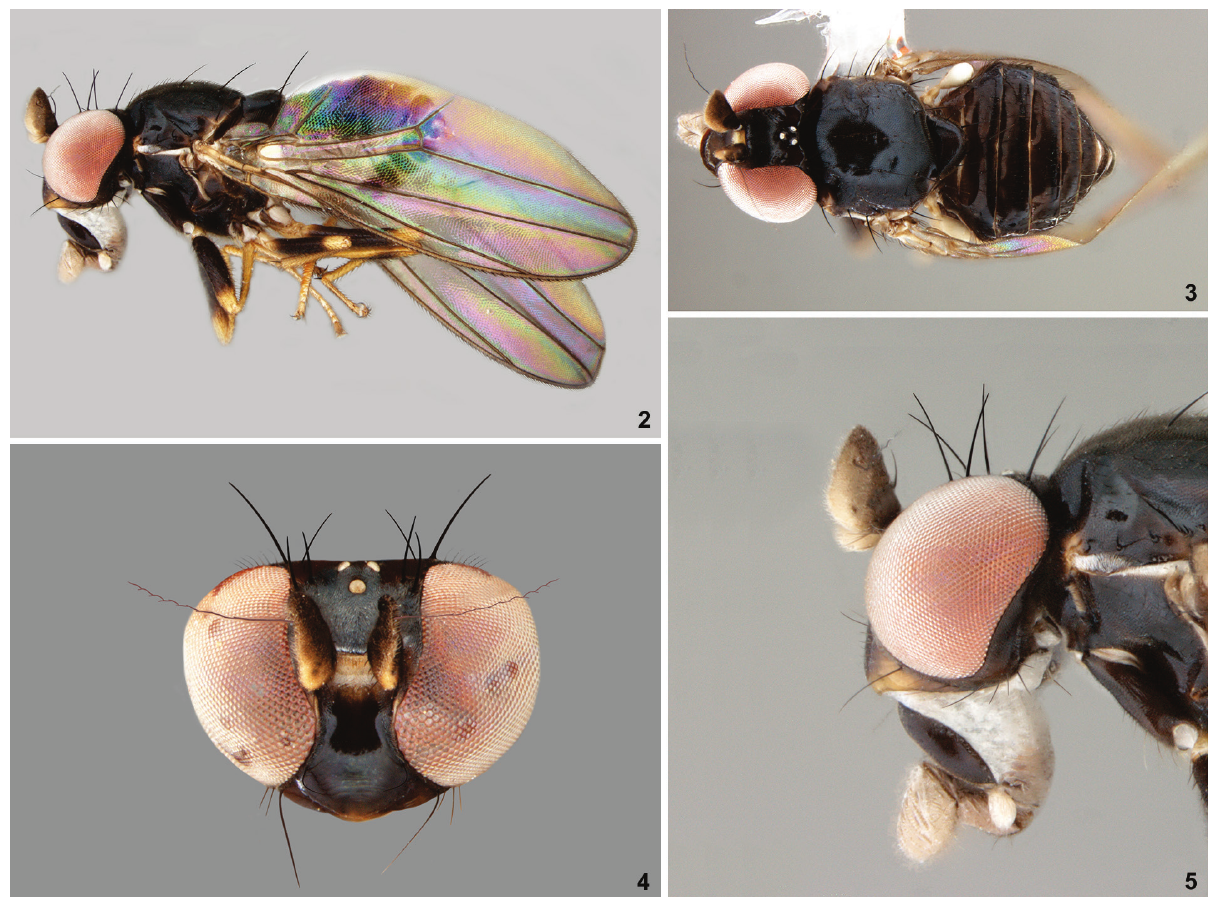
Figures 2–5. Digital photographs of Aulacigaster zurqui sp. nov., paratype female: (2) habitus, lateral view; (3) habitus, dorsal view; (4) head, forntal view; (5) head, lateral view. Specimen is 2.6 mm long. Not all to the same scale.